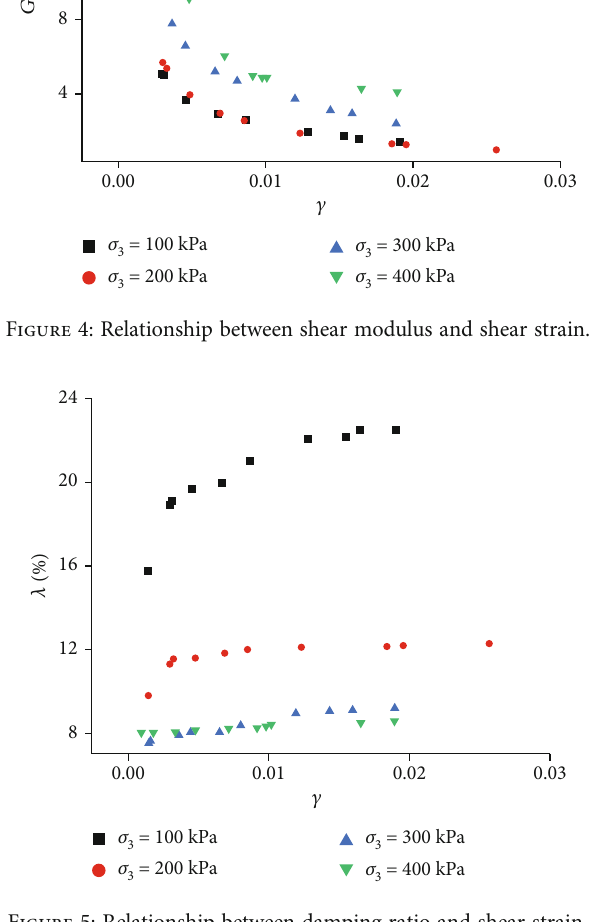
Figure 5: Relationship between damping ratio and shear